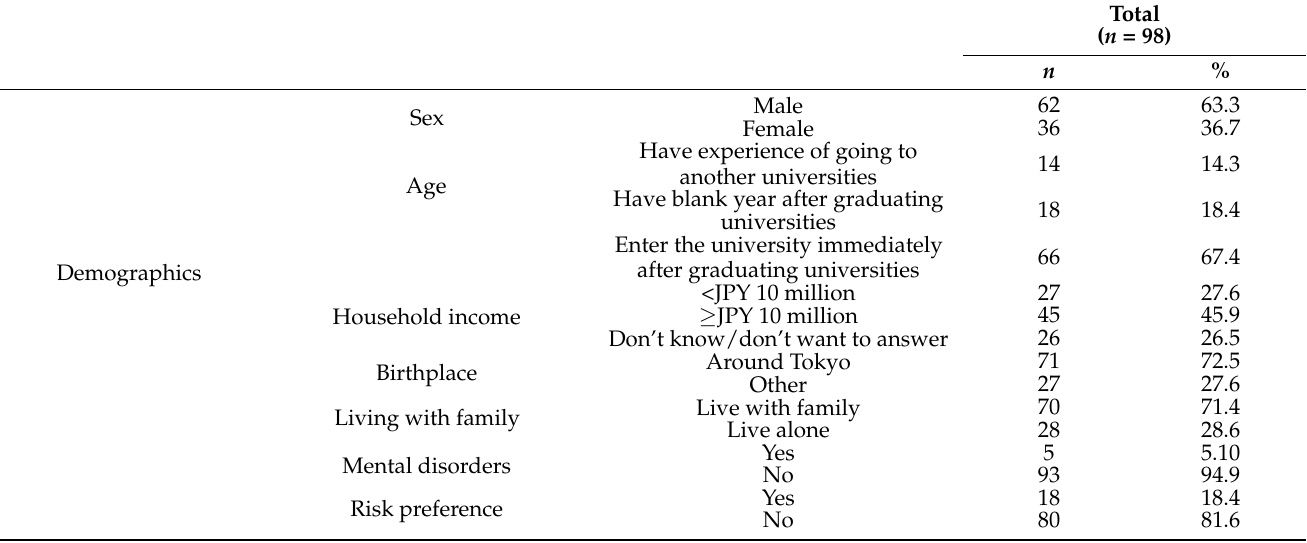
Table 1. Characteristics of